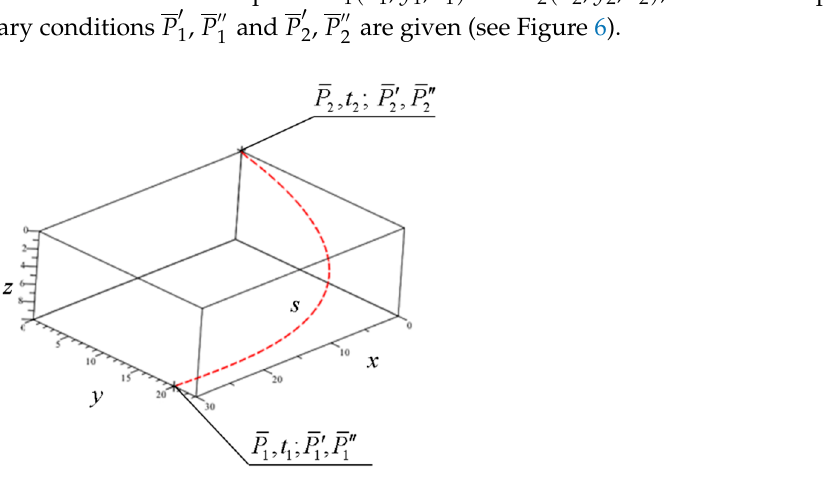
Figure 6. Initial conditions for construction of a fifth-degree Hermite spline curve segment.